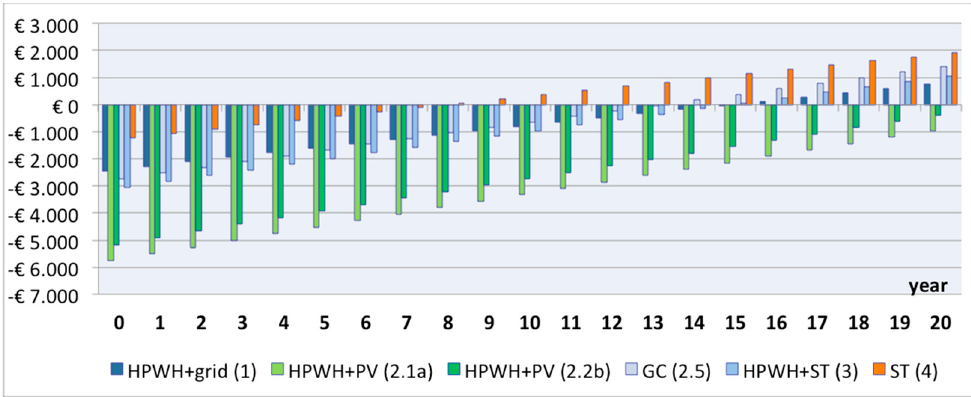
Figure 19. Cash flow and net present value of selected solutions (without national incentive).